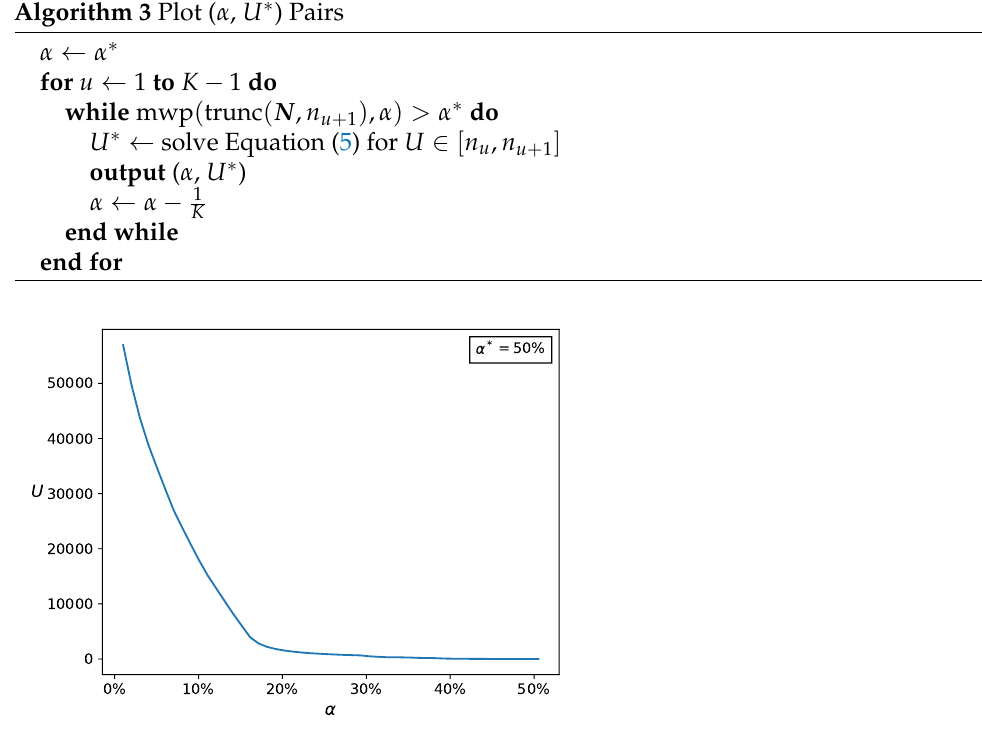
Figure 1. Example plot of data generated by executing Algorithm 3 on unbalanced vector N and α ∗ = 50% (this vector corresponds to the partition used in our experiments; see Section 3.1 for